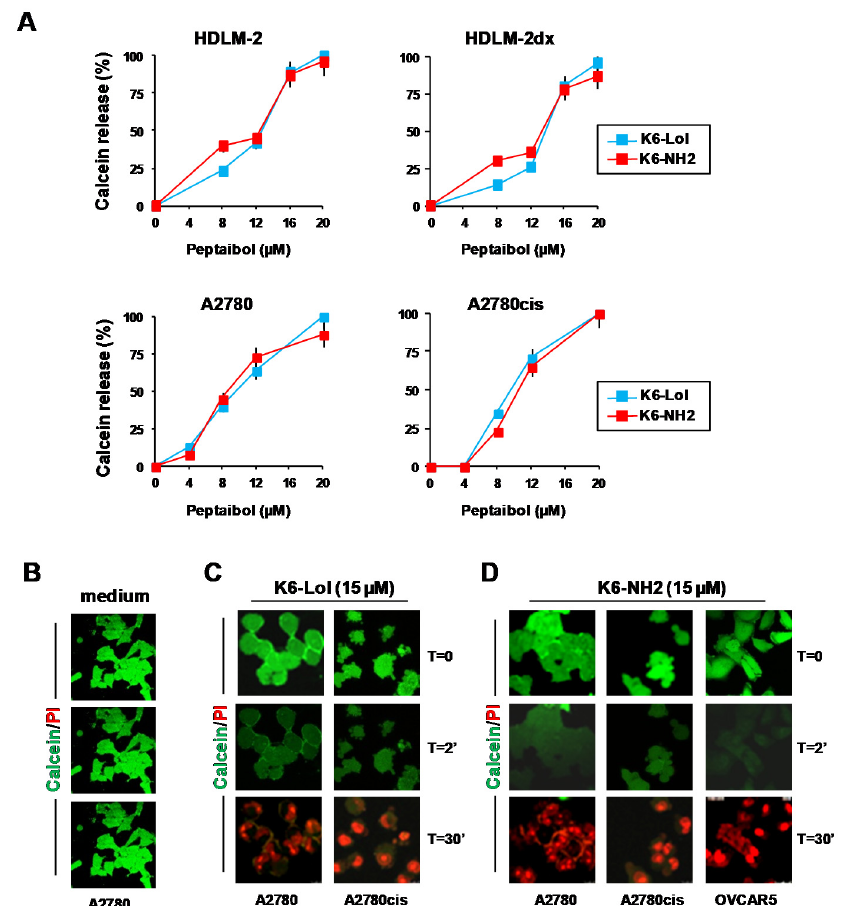
Figure 6. K6-Lol and K6-NH2 rapidly induce calcein release and cell death in OvCa cells. Membrane permeability assays. ( A ) To monitor the lack of the cell membrane integrity after peptaibols treatment, tumor cells were prestained with calcein AM. Then, cells were treated with peptaibols (0–20 µ M) and fluorescent calcein in supernatants was evaluated immediately (2 min). Results are expressed as the percentage of calcein released by cancer cells with respect to cells disrupted with triton X (100%, total fluorescent calcein converted to a green fluorescent form by cancer cells). Bar charts are mean and SD of three independent experiments. ( B – D ) Cell-based calcein release assay evaluated by confocal microscopy. OvCa cells were preincubated with calcein AM (green staining), then stained with PI (to evaluate dead cells) (red staining) and treated with peptaibols. ( B ) Then, untreated cells (medium) and ( C , D ) cells treated with peptaibols (15 µ M) were monitored for calcein AM release by real-time fluorescence using the Operetta